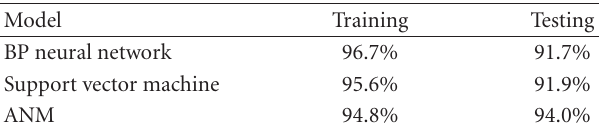
Table 1: Average di ff erentiation rates of di ff erent models with the Iris dataset.